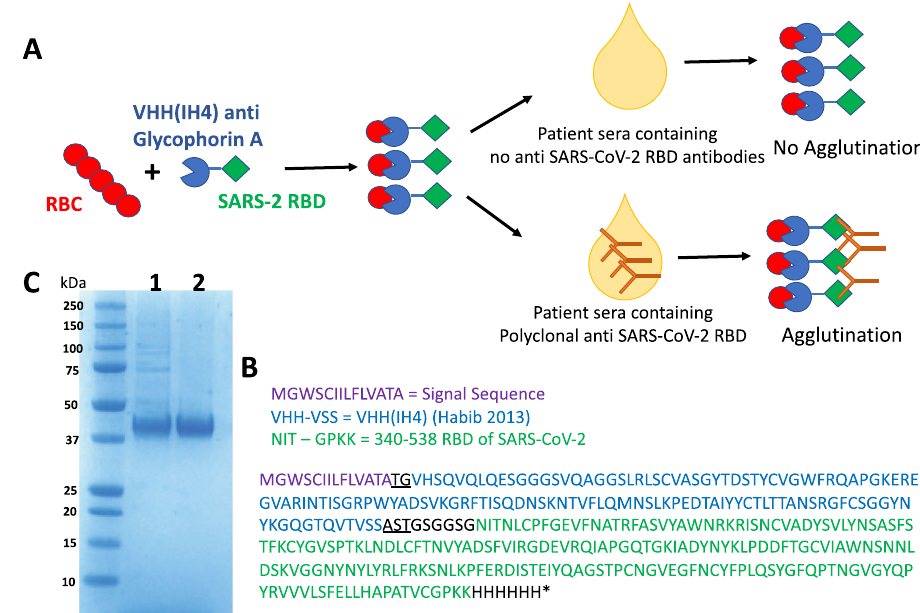
Fig. 1 Haemagglutination test (HAT) for detection of antibodies to SARS-CoV-2 receptor binding domain. A Concept of the HAT. B Sequence of VHH (IH4)-RBD fusion protein. Residues underlined are encoded by cloning sites AgeI (TG) and SalI (AST). The codon-optimised cDNA sequence is shown in Supplementary Information. C SDS-PAGE gel of puri fi ed VHH(IH4)-RBD proteins. Three micrograms of protein were run on 4 – 12% Bolt Bis-Tris under reducing conditions. 1: IH4-RBD produced in house in Expi293F cells. 2: IH4-RBD produced by Absolute Antibody, Oxford, in HEK293 cells. This was done twice with similar results.